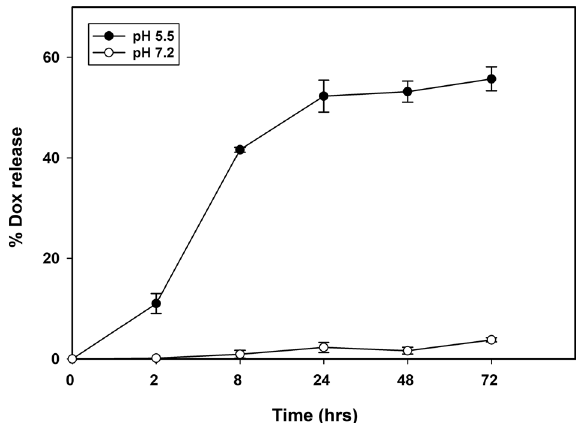
Figure 4. In vitro release profile of doxorubicin from Dox_tLyp-1_S268K VLPs at pH 7.2 and 5.5. Data was collected at 2, 8, 24, 48 and 72 h respectively at 37